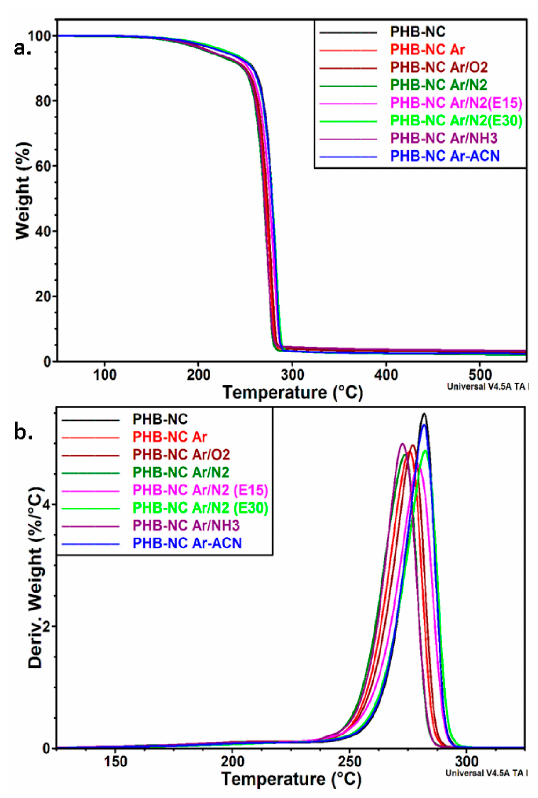
Figure 10. TGA ( a ) and DTG ( b ) curves for poly (3-hydroxybutyrate) (PHB) nanocomposites containing plasma functionalized NC. Table 5. Thermal ( T on and T max ) and mechanical characteristics (tensile strength and Young’s modulus) of PHB-NC